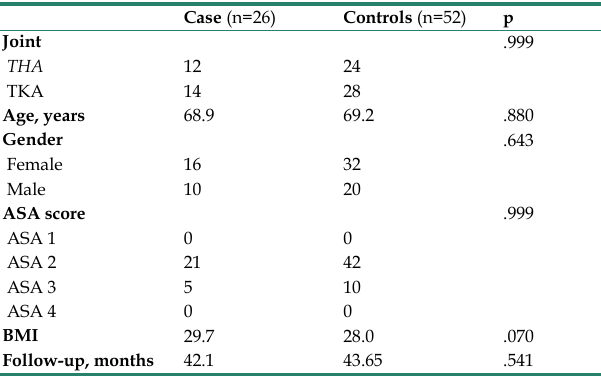
Table 2. Demographic data of infected and control patients